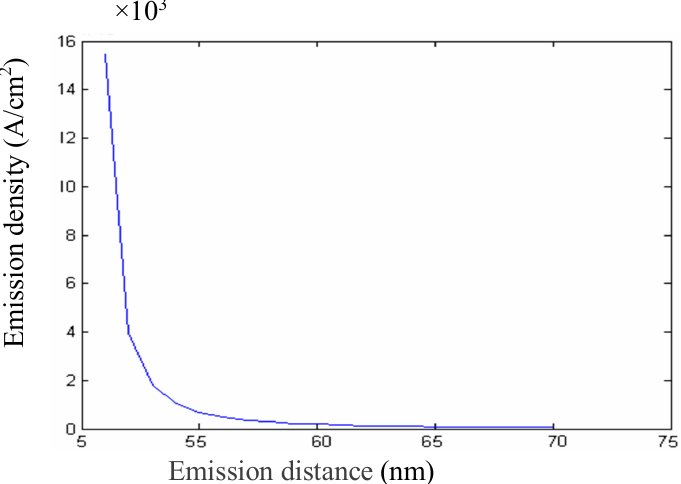
Figure 1. Emission current density vs distance between the cathode tips and the anode.